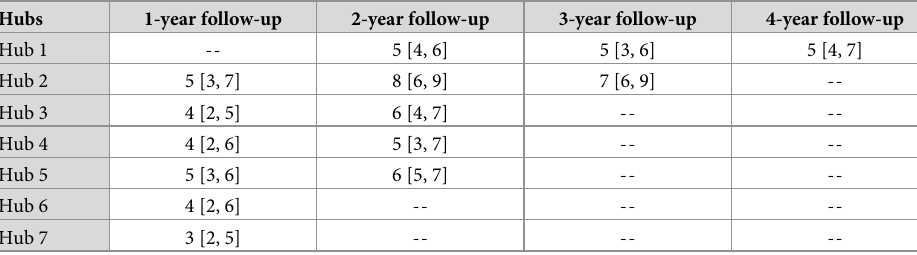
Table 3. Median and interquartile range of counseled antenatal care home visits.